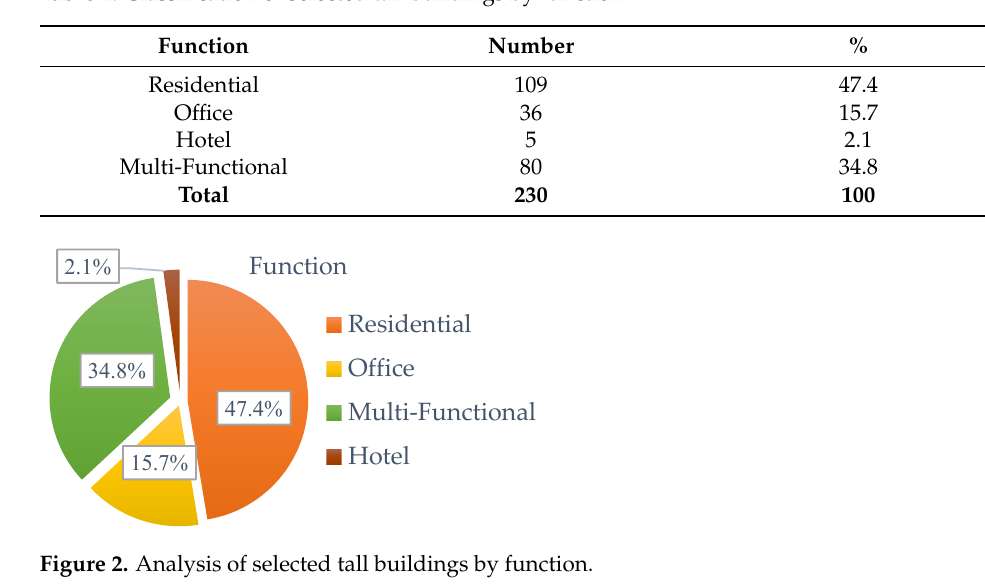
Table 1. Classification of selected tall buildings by function.